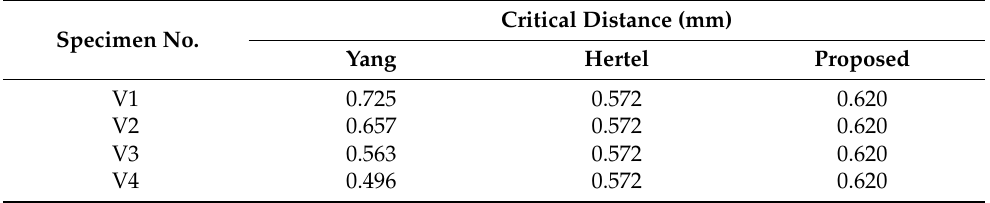
Table 4. Critical distance of Q345qD notched specimens based on different critical distance